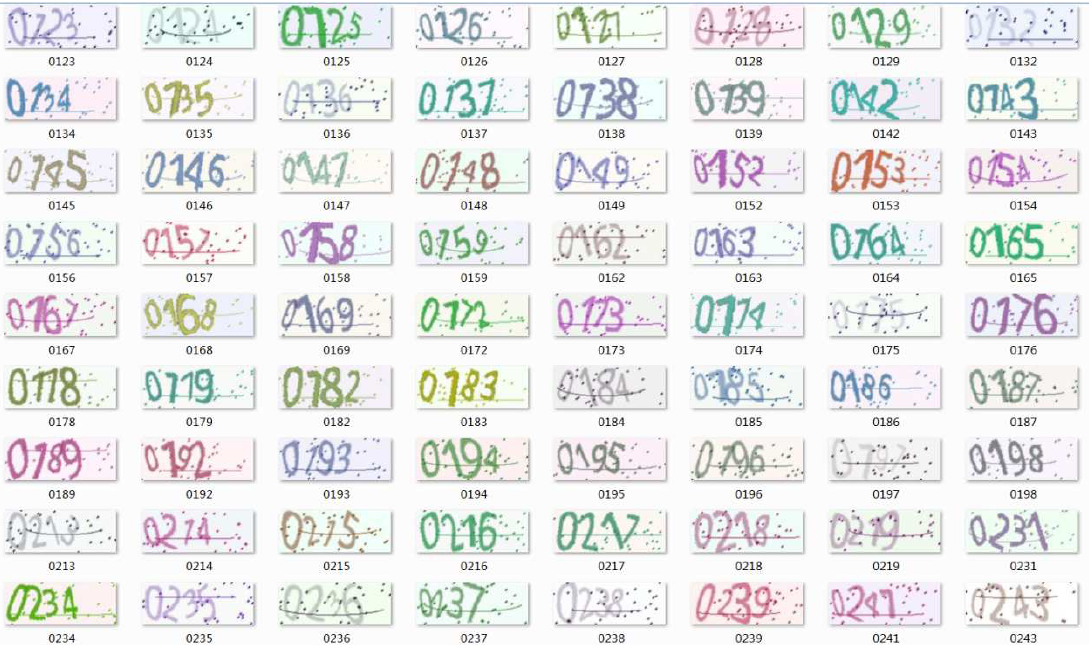
Figure 5. Some captchas in the training set and testing set generated by the traditional text captcha generation